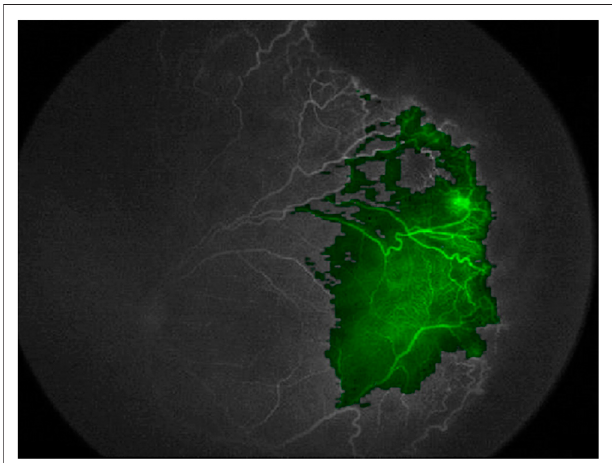
FIGURE 12 | Using a heatmap to visualize areas of an image that contributed to the output ofa deep learning model (Fluoresceine